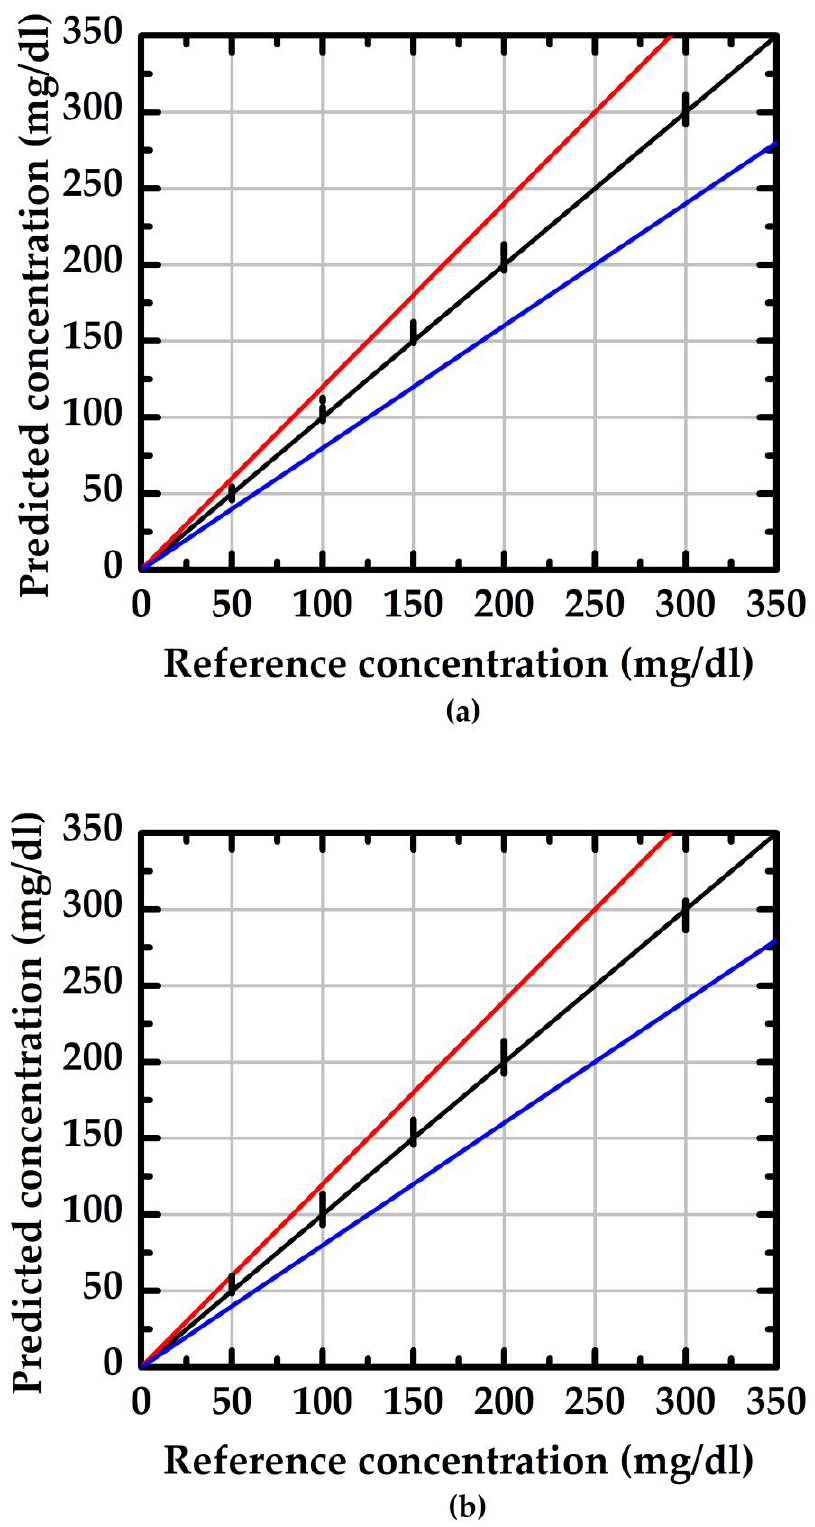
Figure 9. The reliability evaluation of the proposed method with different length of the undoped type NWGS. ( a ) nanowire lengths of 3.5 μ m; ( b ) nanowire lengths of 5.3 μ m.